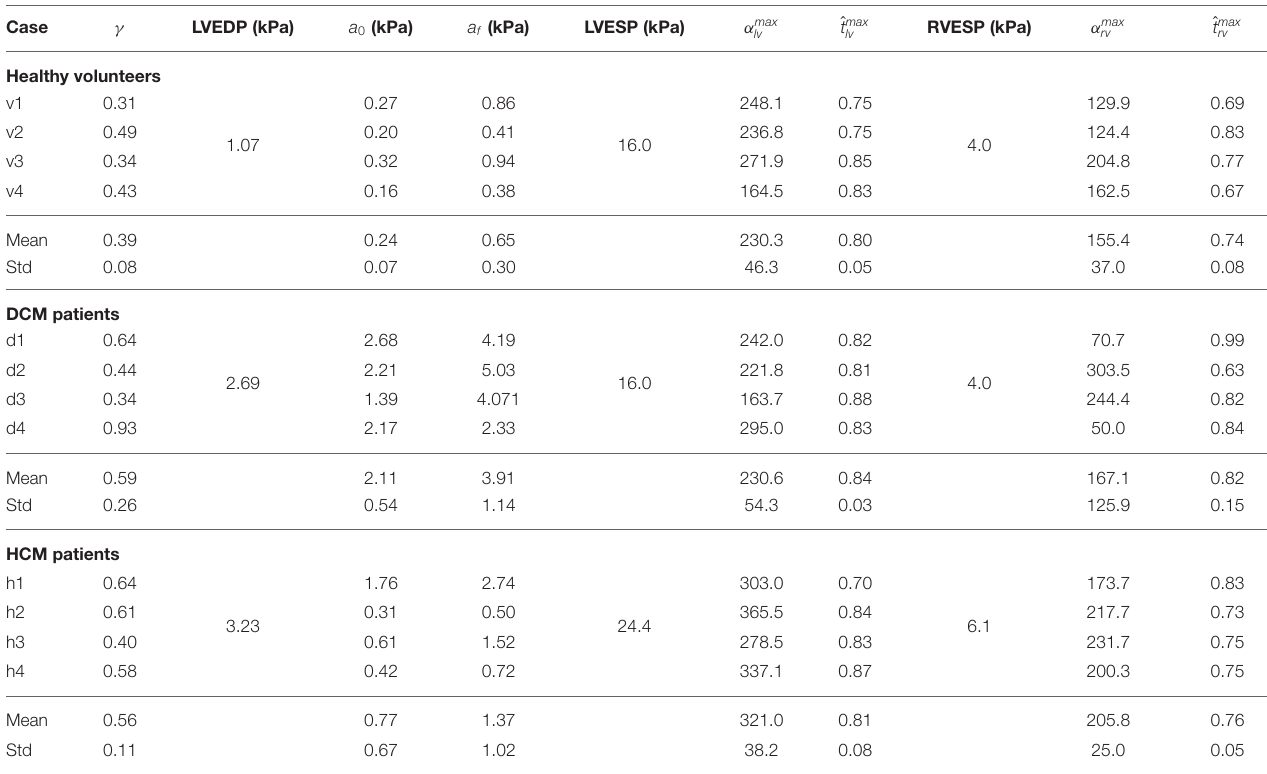
TABLE 3 | Personalised passive and active parameters.